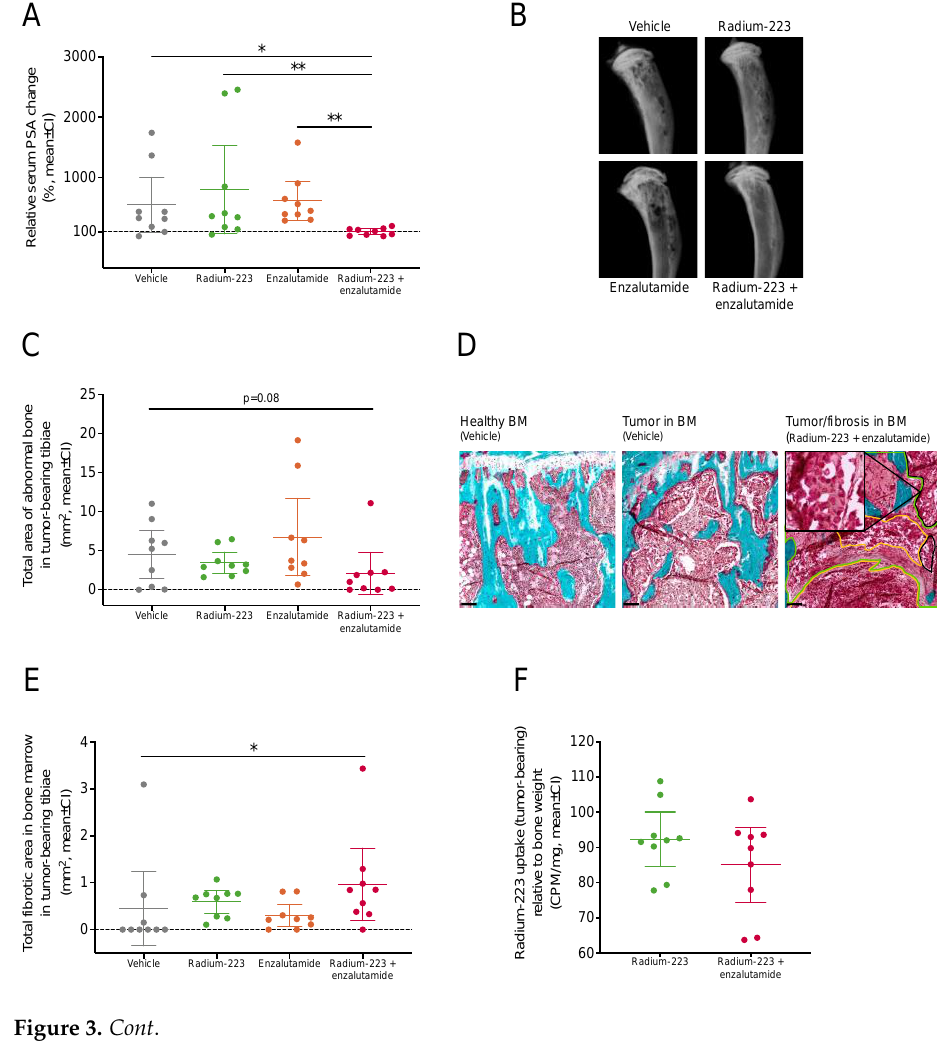
G Figure 3. Cont